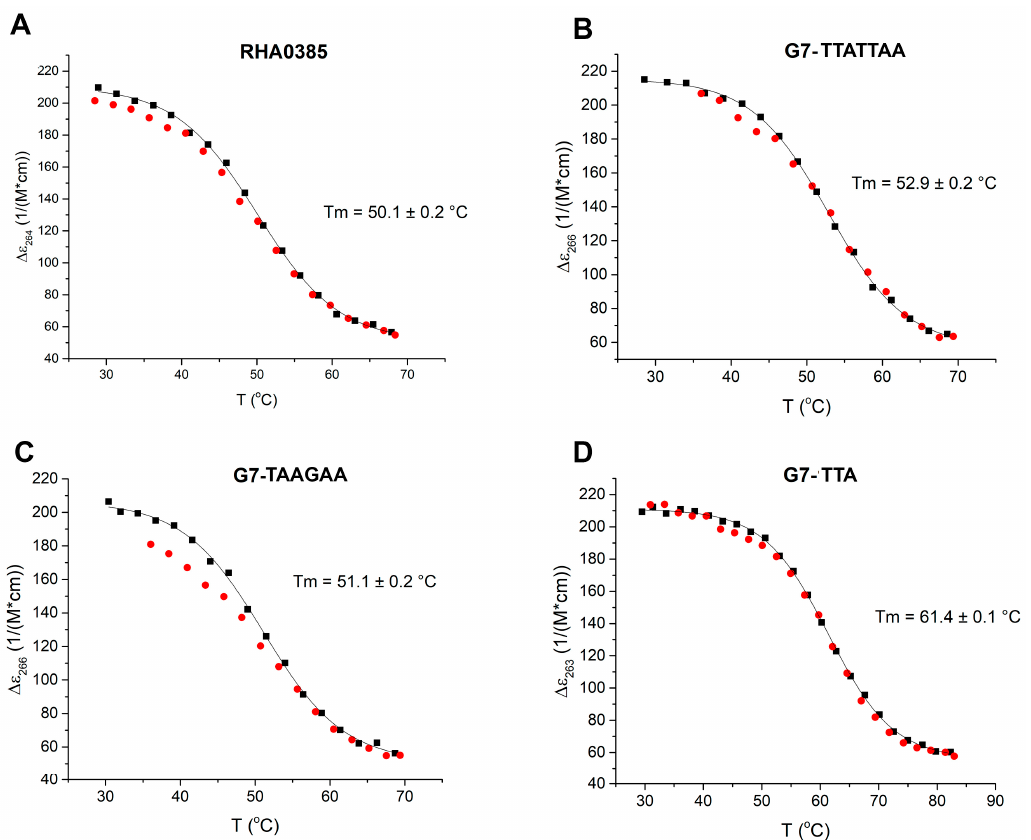
Figure 3. The melting (black dots) and annealing (red dots) curves of ( A ) RHA0385, ( B ) G7-TTATTAA, ( C ) G7-TAAGAA, ( D ) G7-TTA. Melting temperatures are indicated. Only one G-quadruplex (G7-TAAGAA) demonstrates hysteresis under the experimental conditions (2 µ M solution in PBSK with overall 10 mM K + , with an average heating ramp of 0.5 °C/min).